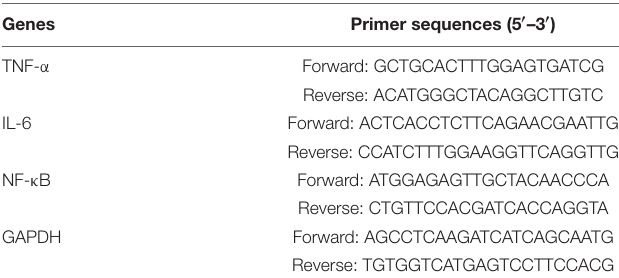
TABLE 1 | Primers used in qPCR